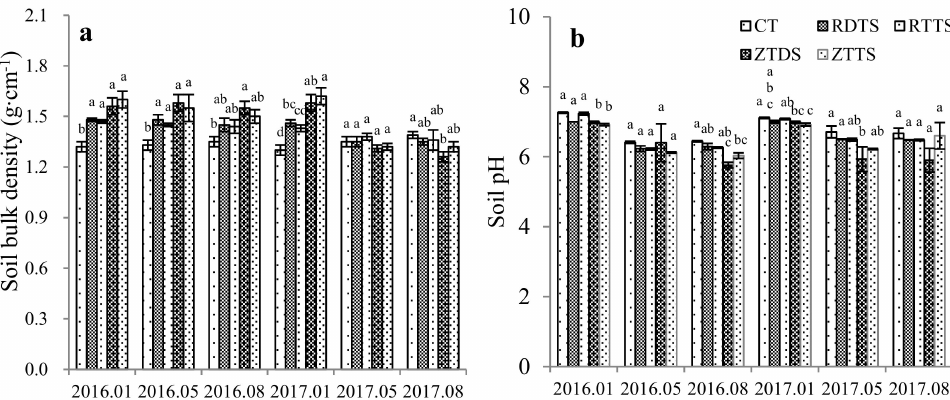
Figure 3. E ff ect of tillage methods on ( a ) soil bulk density; ( b ) soil pH for 2016 and